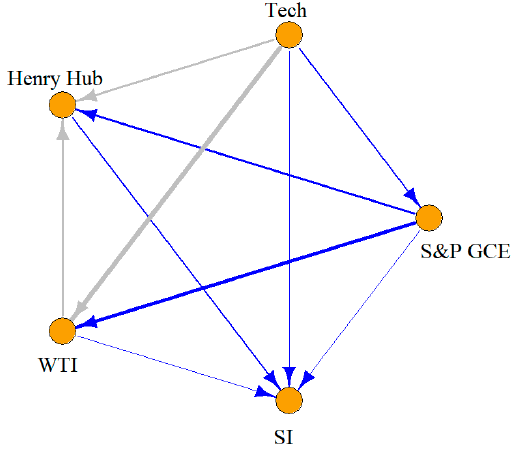
Figure 2. Net pairwise directional return connectedness. Note: S&P GCE, Standard & Poor Global Clean Energy Index; Henry Hub, Henry Hub Natural Gas Futures; WTI, West Texas Intermediate Crude Oil Futures; Tech, NYSE Arca Tech 100 Index; SI, investor sentiment index.